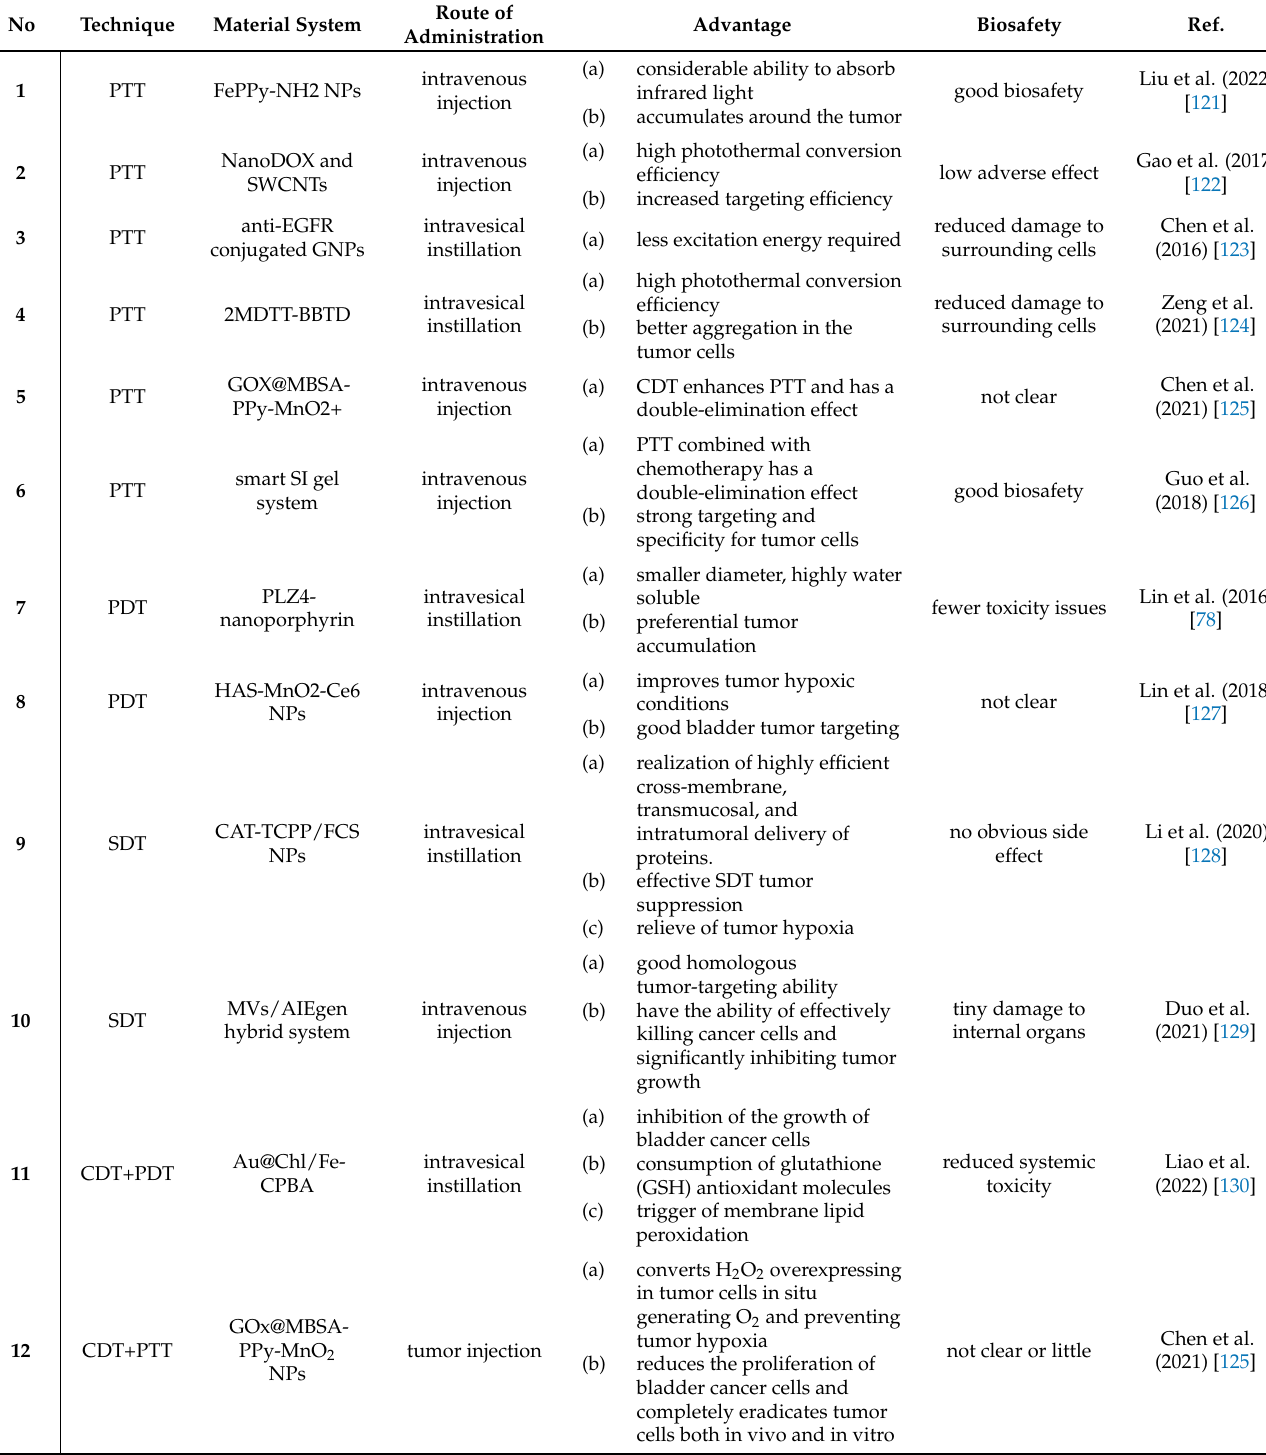
Table 4. Summary of the other nanomedicine-specific bladder cancer